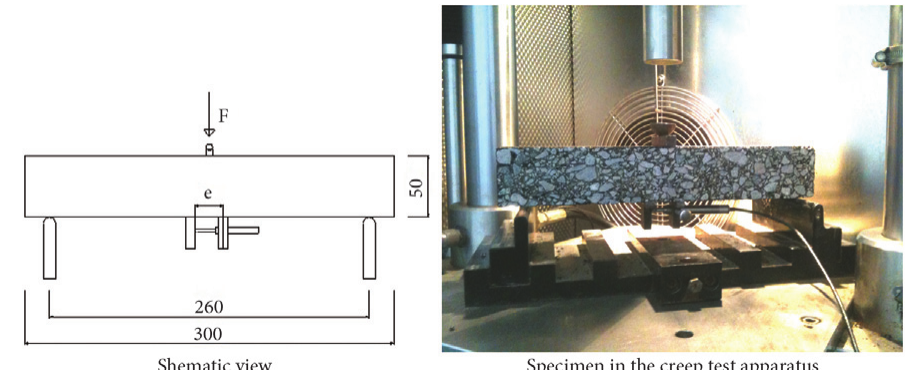
Fig. 3. Bending creep test – the test